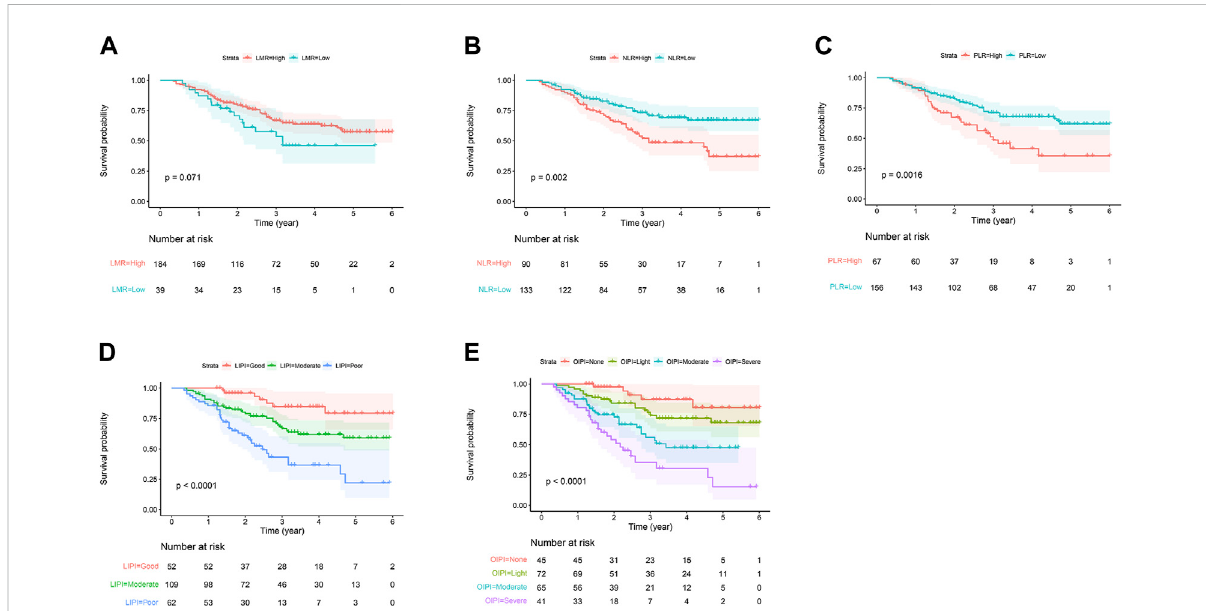
FIGURE 2 PredictiveabilityofdifferenthematologicalbiomarkersonOSin223patientswithosteosarcoma. (A – E) Prognosticpredictiveeffectofdifferent in fl ammatory biomarkers on OS. Cumulative hazard function was plotted by the Kaplan – Meier methodology and the p value was calculated with two-sided log-rank tests. According to the logistic regression analysis, the differences between four LIPI or OIPI groups in the survival probability were signi fi cant. OS, overall survival; LMR, lymphocyte-monocyte ratio; NLR, neutrophil – lymphocyte ratio; PLR, platelet – lymphocyte ratio; LIPI, Lung Immune Prognostic Index; OIPI, osteosarcoma immune prognostic index.